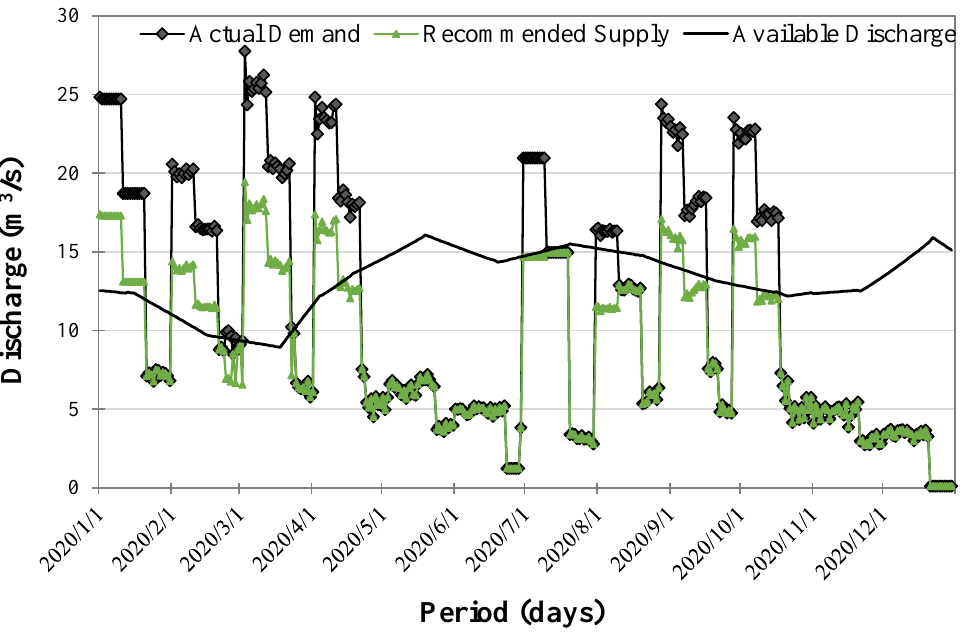
Figure 13. Projected daily available discharges for irrigation supply, actual water demand and recommended irrigation supply from multi-models for RCP 8.5 scenario from 1 January to 31